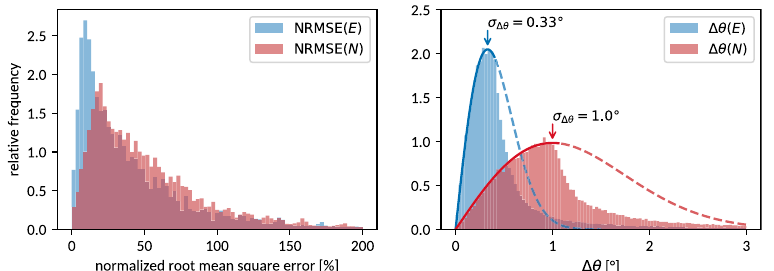
Figure 6. Histograms showing the normalized root mean square errors (NRMSE, cf. Eq. 8) and angular deviations (Eq. 9) of the fitted approximative tensor models with respect to the synthesized dark-field data and mass distribution tensors. The angular deviations are compared to (unnormalized) Gaussian distributions of inclination angles (integrated over the azimuthal degree of freedom, cf. Eq. 10). These are found to describe the empiric distributions up to their maximum and are used for quantification